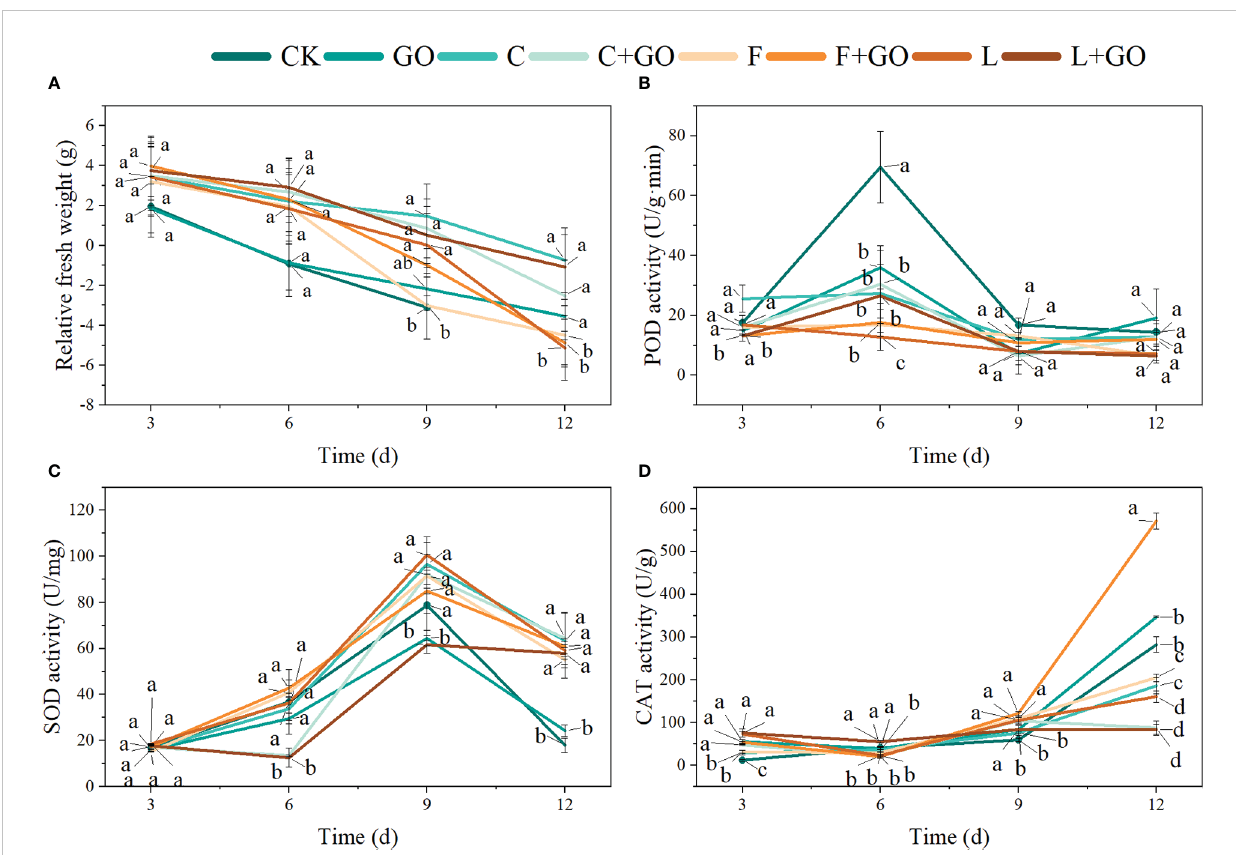
FIGURE 3 Effects of different treatments on the relative fresh weight, and the activities of superoxide dismutase (SOD), peroxidase (POD), and catalase (CAT) in the petals of the cut rose fl owers. (A) Relative fresh weight. (B) POD activity. (C) SOD activity. (D) CAT activity. Different lowercase letters indicate signi fi cant difference among different groups at p<